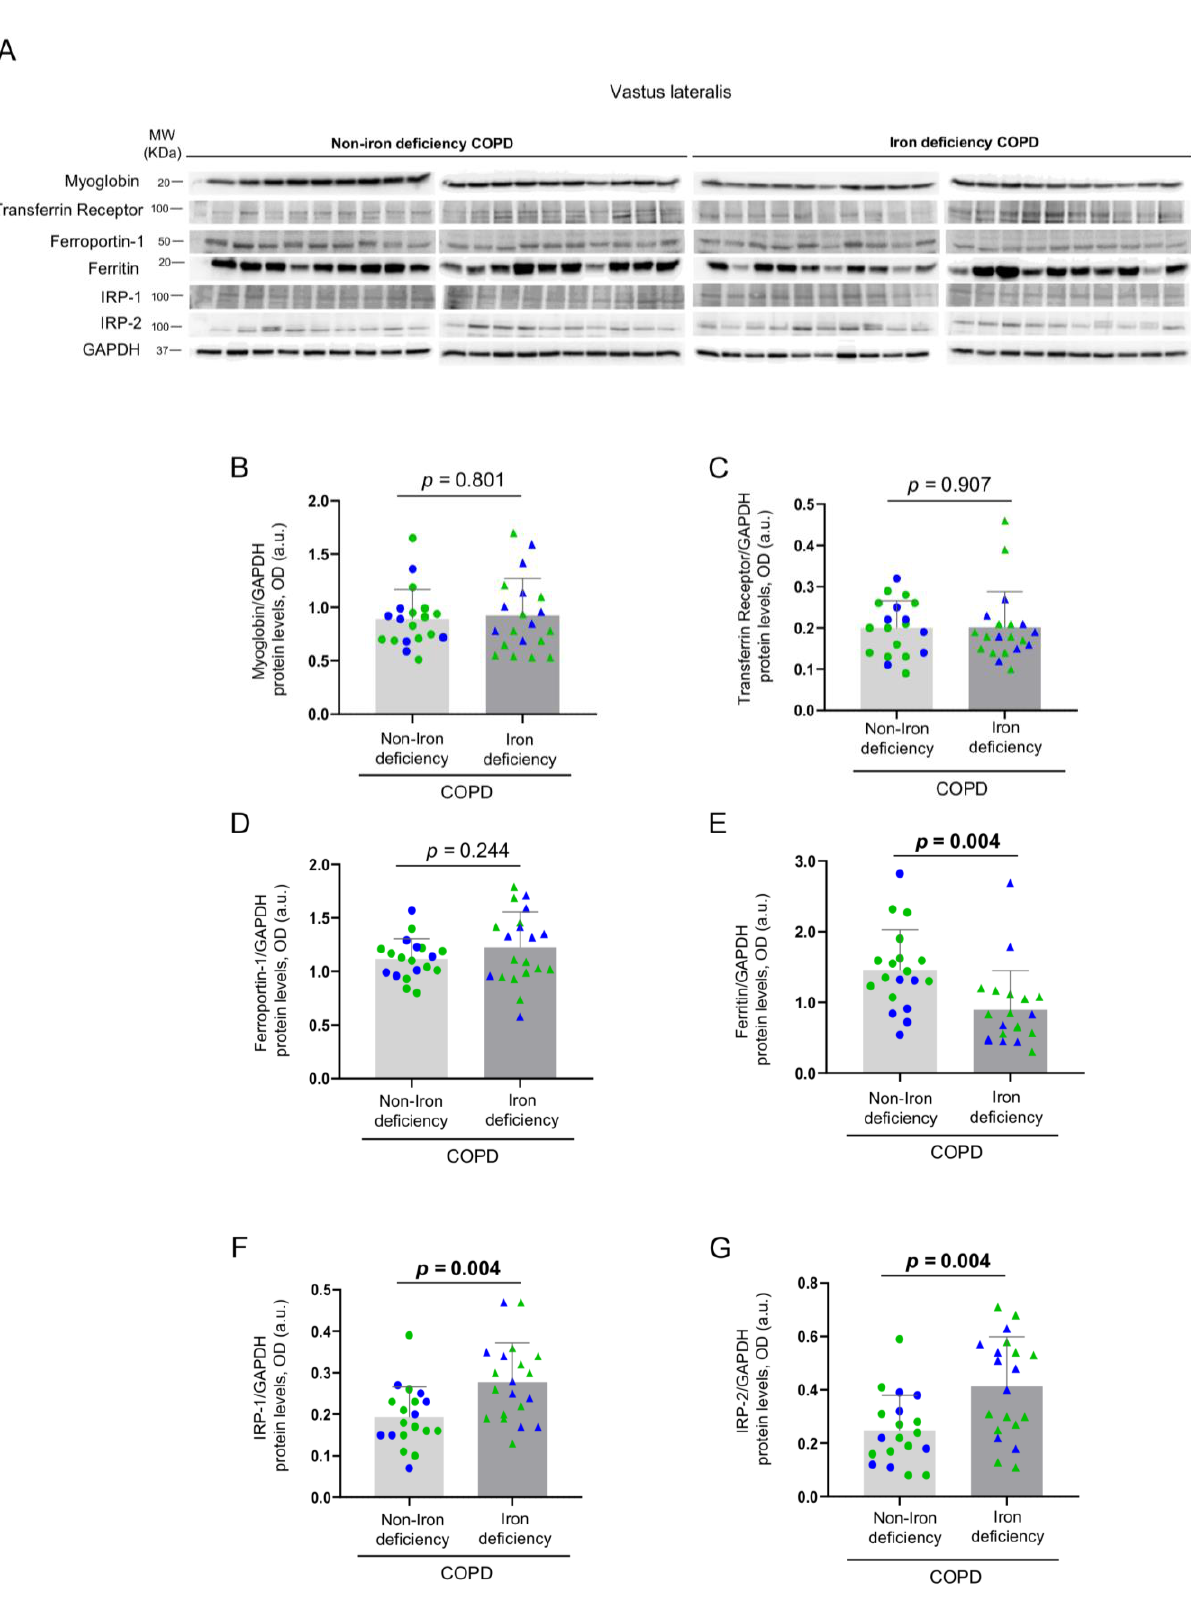
Figure 8. Representative immunoblots of myoglobin, transferrin receptor, ferroportin-1, ferritin, IRP-1, IRP-2 and GAPDH proteins in the vastus lateralis of all COPD patients ( A ). Mean values and standard deviation of myoglobin ( B ), transferrin receptor ( C ), ferroportin-1 ( D ), ferritin ( E ), IRP-1 ( F ) and IRP-2 ( G ) protein content as measured by optical densities in arbitrary units (OD, a.u.). In the graphs, the green color dots or triangles indicate male patients in either study group, while the